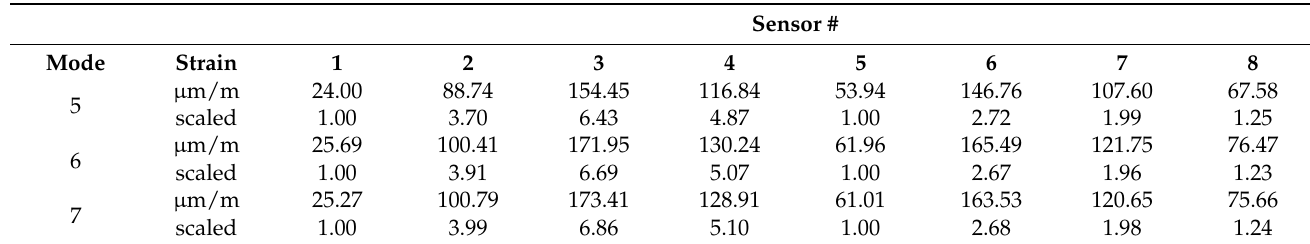
Table A3. Strain sensor data for the undamaged plate excited with 3 V amplitude.